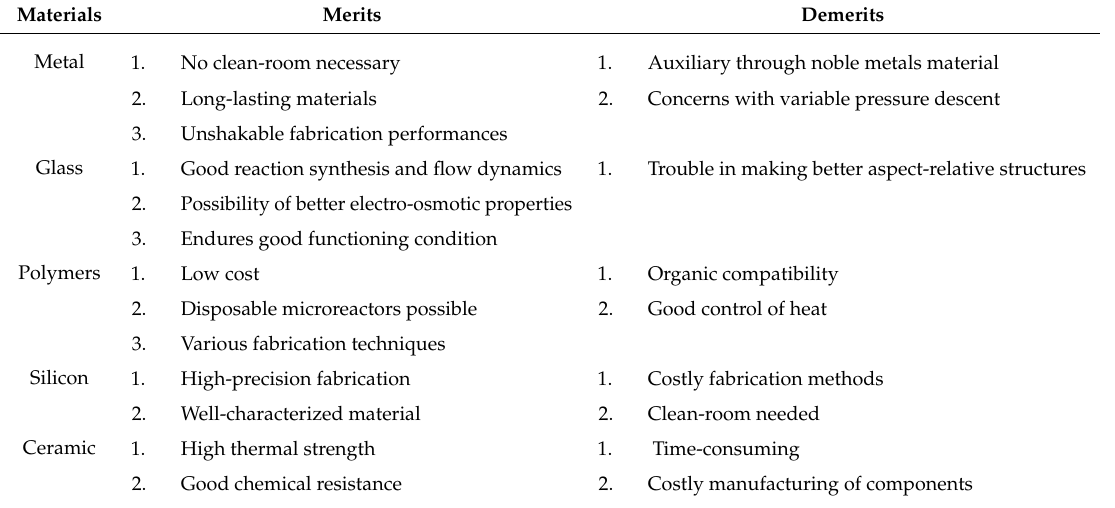
Table 1. Merits and demerits of the distinctive constituents used for microreactor